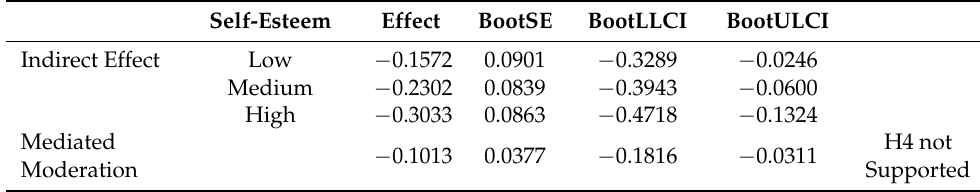
Table 2. Moderated Mediation Indirect Effect of Organizational